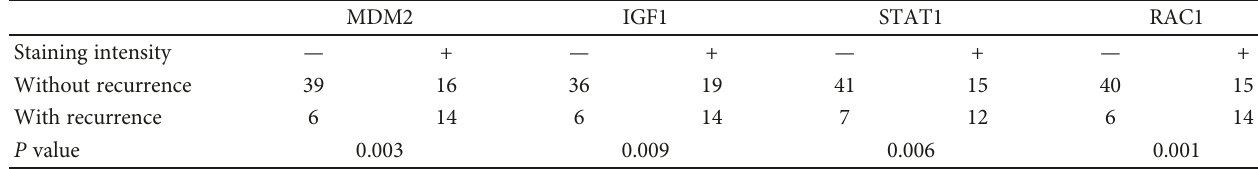
Table 2: Association between expression of MDM2, IGF1, STAT1, and RAC1 and the recurrence of GCT.